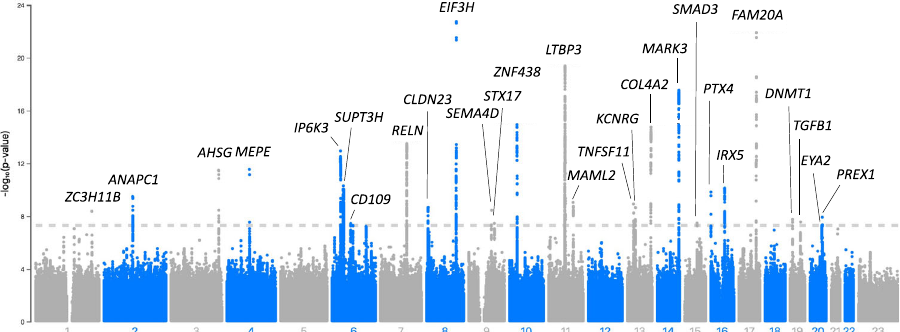
Fig. 1 | Meta-analysis ofthe genome-wideassociationstudies ofotosclerosis in FinnGen,EstBBandUKBB. GWASforeachindividualstudycohortwasperformed using a generalized mixed model with the saddlepoint approximation using SAIGE v0.20, using a kinship matrix as a random effect and covariates as fi xed effects. Results are presented for a fi xed-effect meta-analysis of effect estimates from the three cohorts, including a total of 3504 cases and 861,198 controls. In the Man- hattan plot, chromosomal positions are indicated on the x-axis and -log 10 ( p -value) ispresentedonthey-axisforeachvariant.Twenty-sevenlocireachedgenome-wide